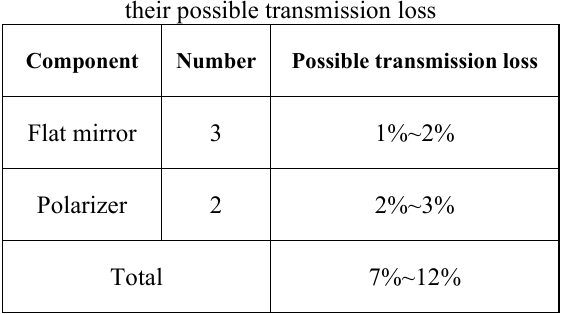
Table . The number of flat mirrors and polarizers